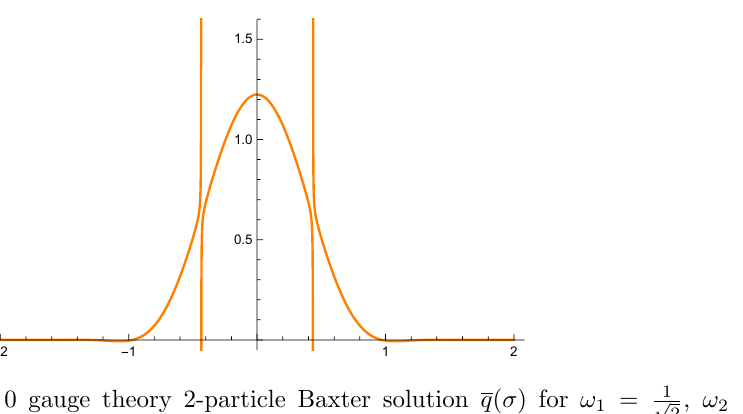
Figure 16. Level n = 0 gauge theory 2-particle Baxter solution q ( (cid:27) ) for ! 1 = 1 p m 0 = (cid:0) ln3 without instanton 2 (cid:25)